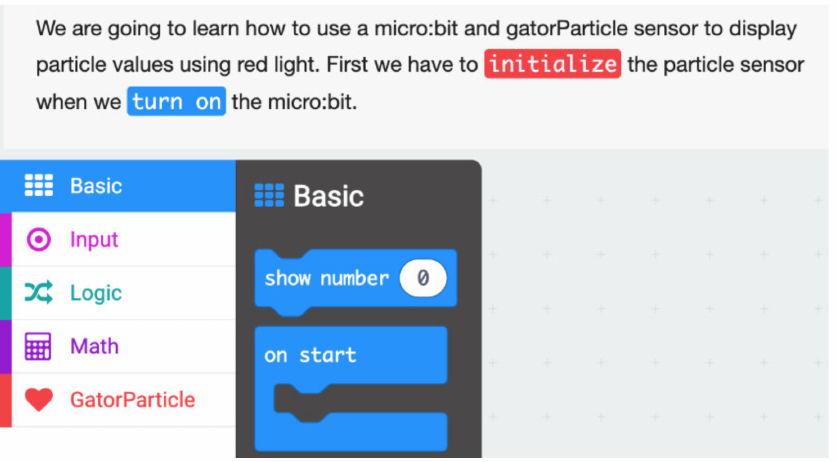
Figure 7. Screenshot of the first step in a tutorial for using the particle sensor. The instructions hint that the student will need to use a basic block and a gator particle block at this step. Only a subset of the blocks is visible to the